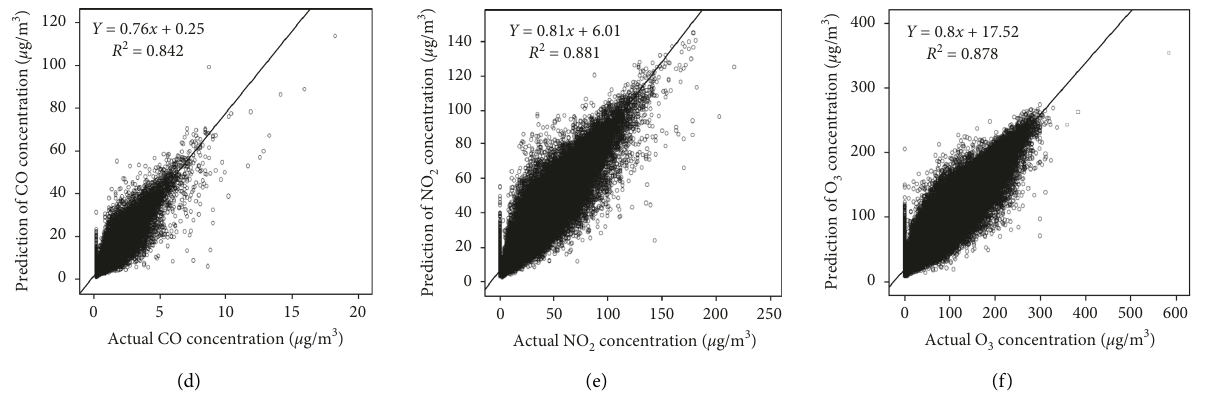
Figure 9: Verification of pollutant concentrations obtained from the random forest model.